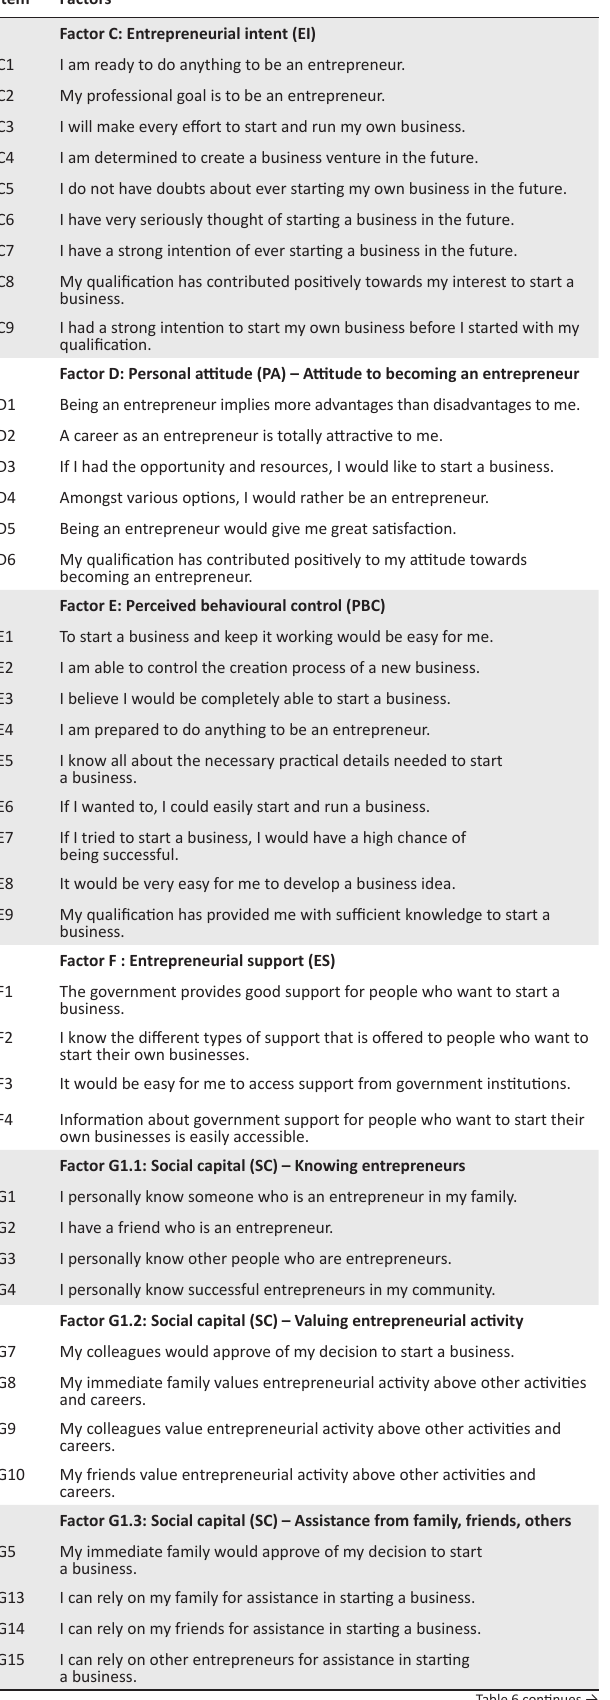
TABLE 6: Factors extracted from the seven scales and their items. Item Factors